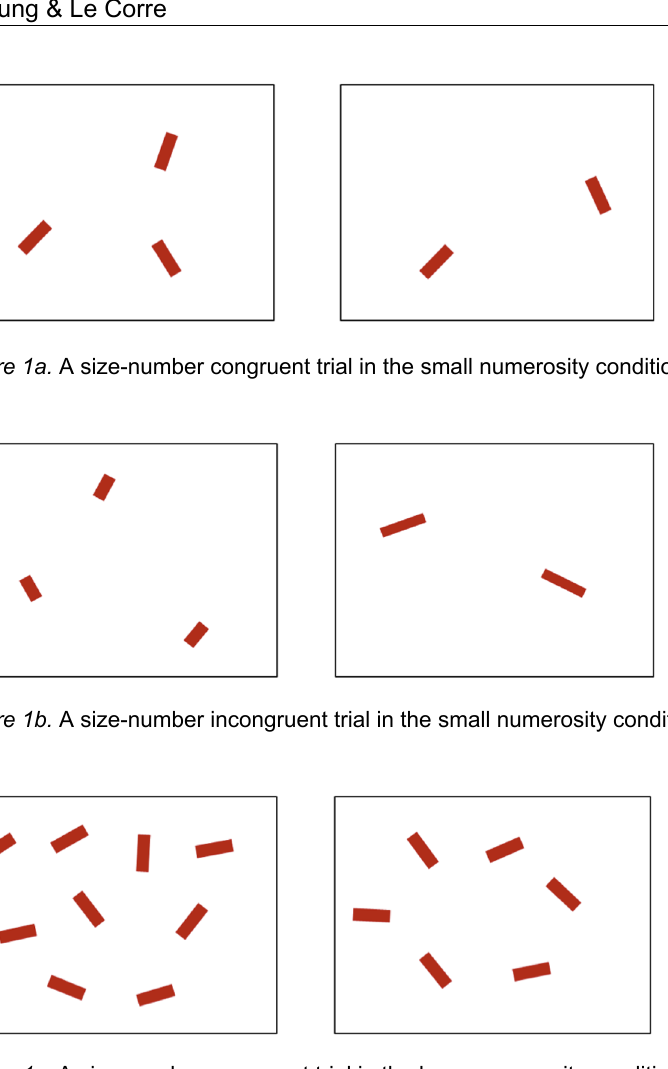
Figure 1c. A size-number congruent trial in the large numerosity condition in Experiment 1.